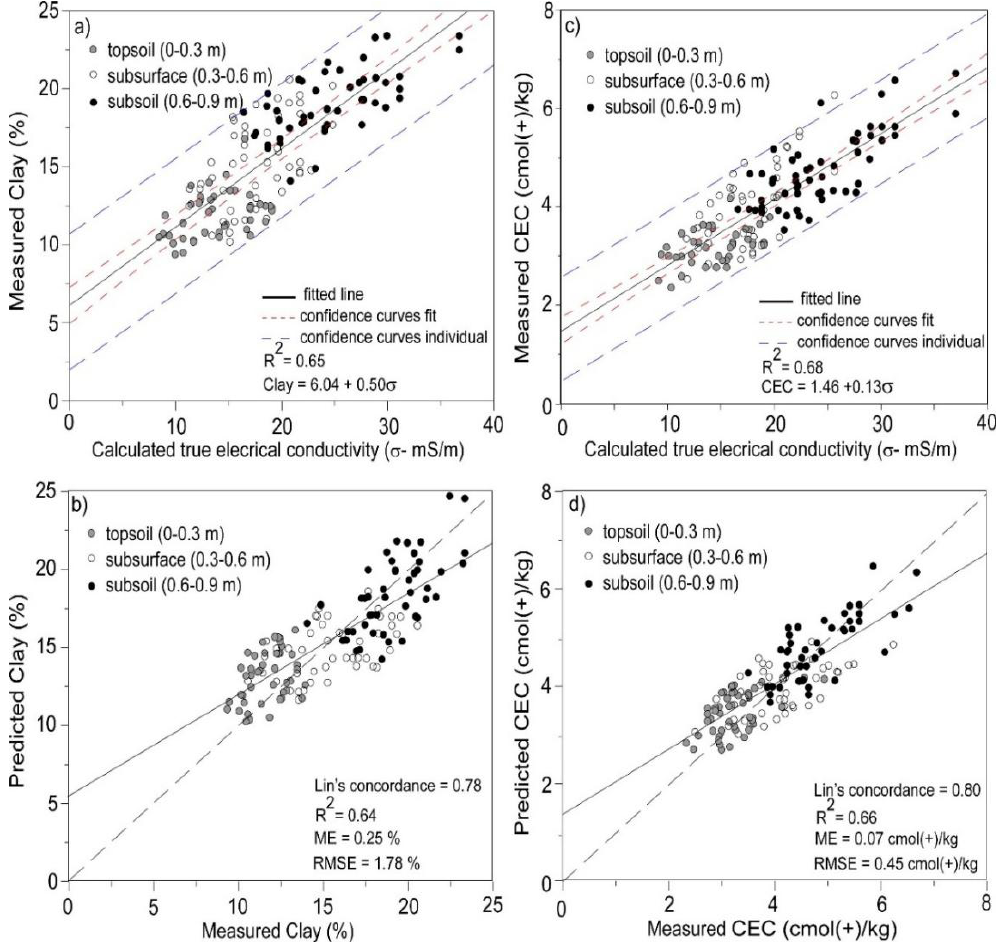
Figure 6. Plots of measured ( a ) clay (%) and ( c ) cation exchange capacity (CEC—cmol(+)/kg) versus true conductivity (σ—mS/m) using λ of 0.07 and 0.9 and S1 inversion algorithm with full solution, respectively; and, plots of measured versus predicted ( b ) clay and ( d ) CEC using leave-one-out cross-validation, for topsoil (0–0.3 m), subsurface (0.3–0.6 m) and subsoil (0.6–0.9 m).